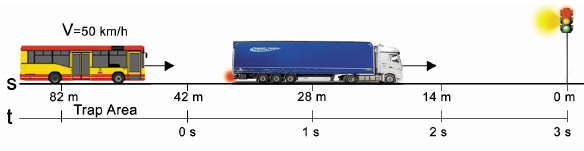
Figure 3: Diagram of the “trap” for a city bus and a long vehicle in front of it, at an intersection with a yellow signal displayed, V p – initial value of the speed of the set of vehicles.